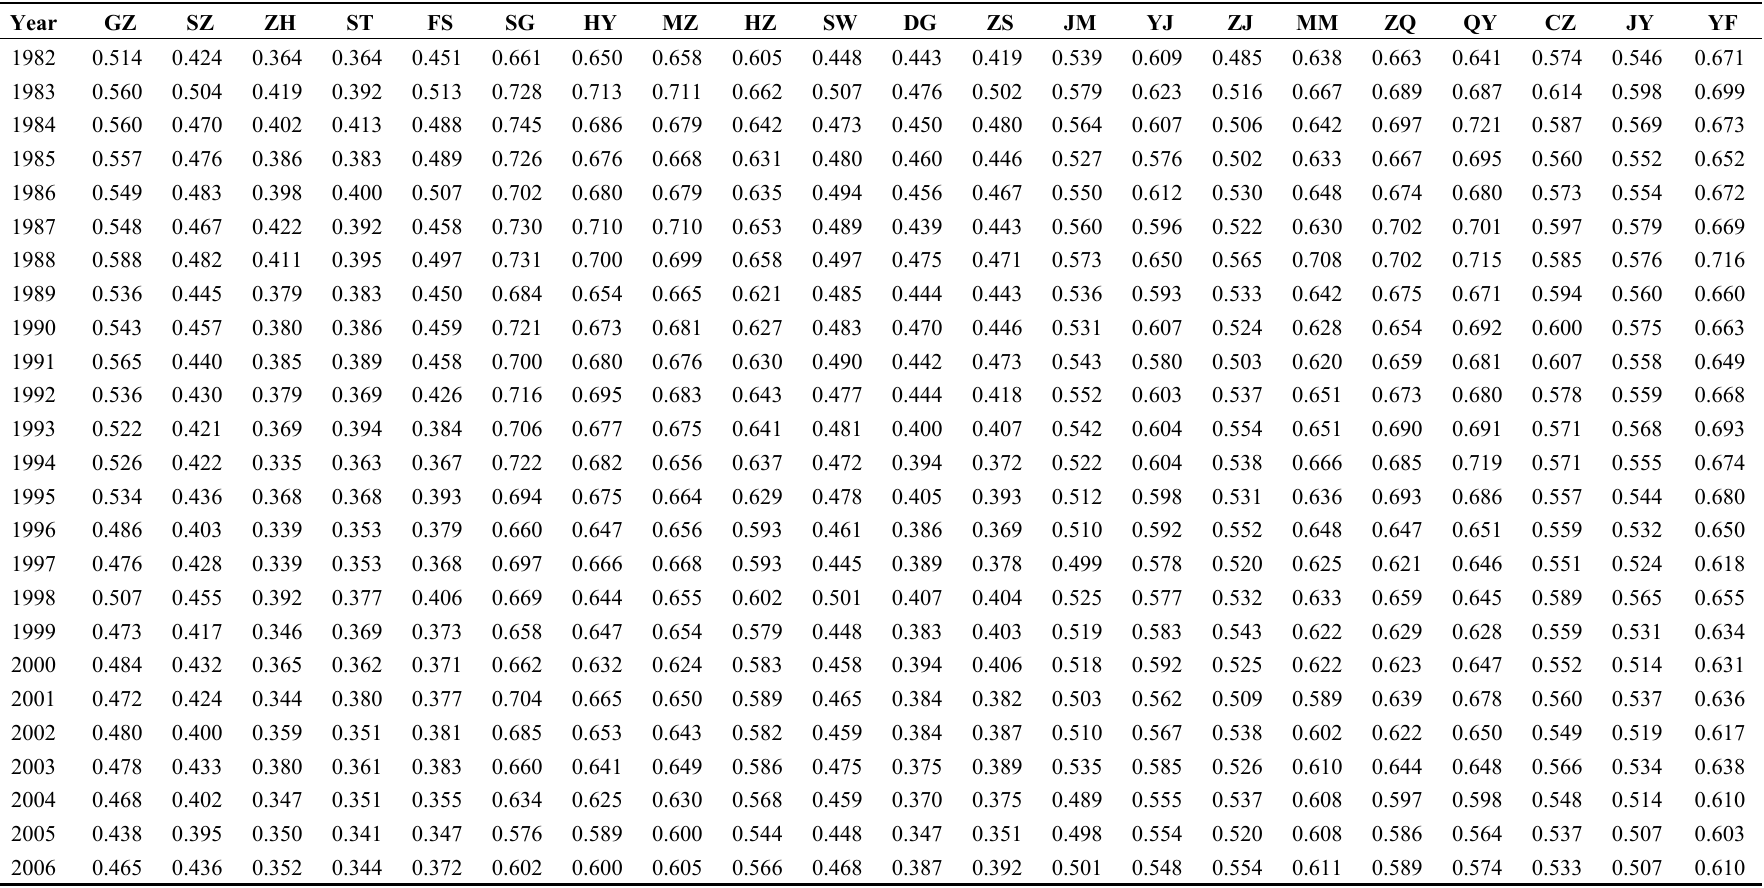
Table A2. The annual maximum NDVI of 21 cities in Guangdong Province from 1982 to